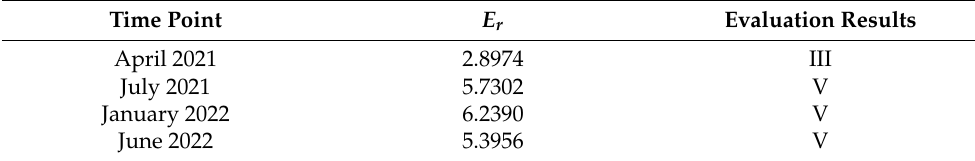
Table 7. Evaluation results for residents’ purchasing intention at different time points.